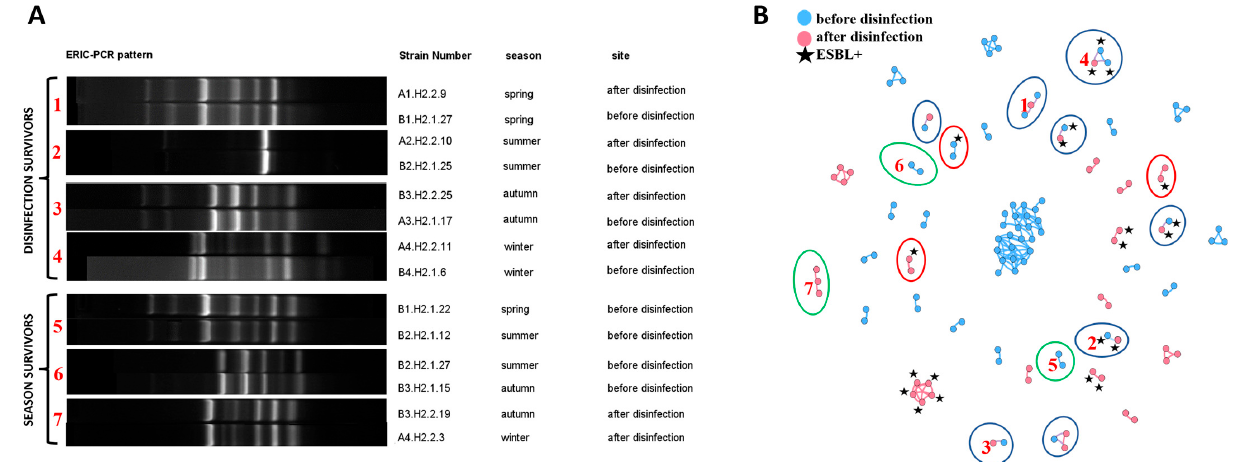
Figure 3. Presentation of clonal relationships: ( A ) Examples of ERIC-PCR fingerprints of isolates regarded as clones: between sampling sites (disinfection survivors) and seasons (season survivors); ( B ) Network analyses showing all clonal relationships within the studied isolates. Blue nodes represent strains isolated from wastewater before disinfection, and pink nodes represent isolates from disinfected wastewater. ESBL+ isolates are marked with a black star. The clones identified in isolates from different sampling sites are marked with a blue ellipse. The clones identified in isolates from different seasons are marked with a green ellipse. Clones that differed in ESBL production are marked with a red ellipse. The connections between nodes represent Pearson’s correlation coefficient of ≥ 97% and the Dice similarity coefficient of 100% (clones). Nodes = 117; Edges = 133. Red numbers in ( A ) relate to the numbers in ( B ) and denote the same bacterial relationships.